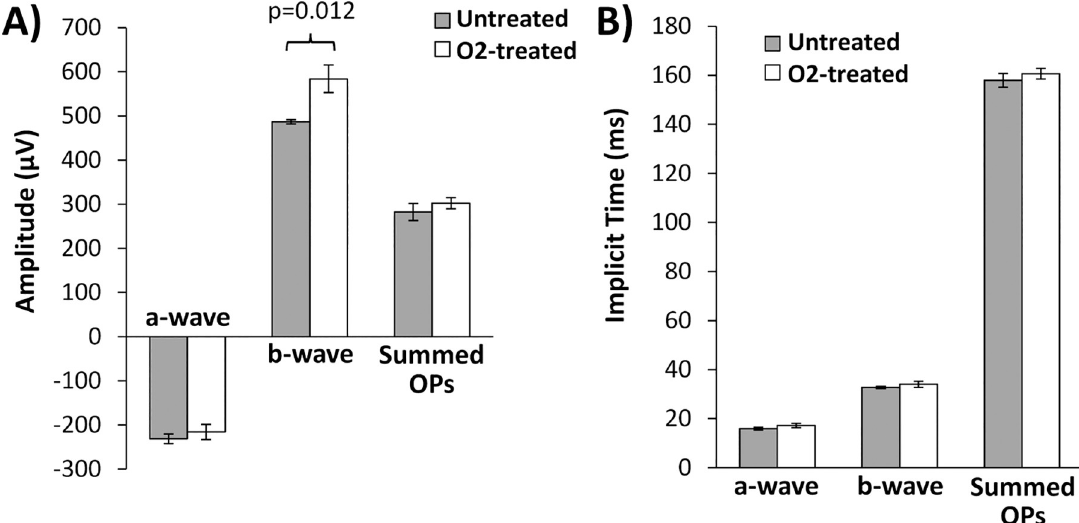
Fig 4. ERG from DBA/2J mice at 9 months of age. Mice were housed under room air (untreated, n = 5) or 30% oxygen (O 2 -treated, n = 10) beginning at 4.5 months. ERG data from both eyes were averaged and the (A) amplitudes and (B) implicit times of the a-wave, b- wave, and summed oscillatory potentials (OPs) are shown. Mean ± SEM. Significant differences are